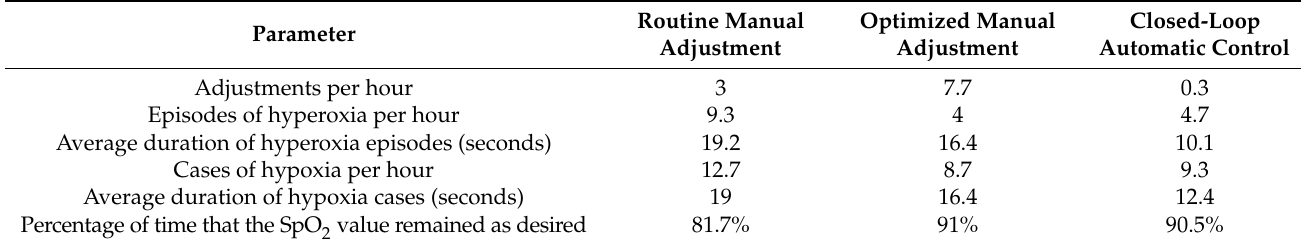
Table 2. Results obtained from the work of